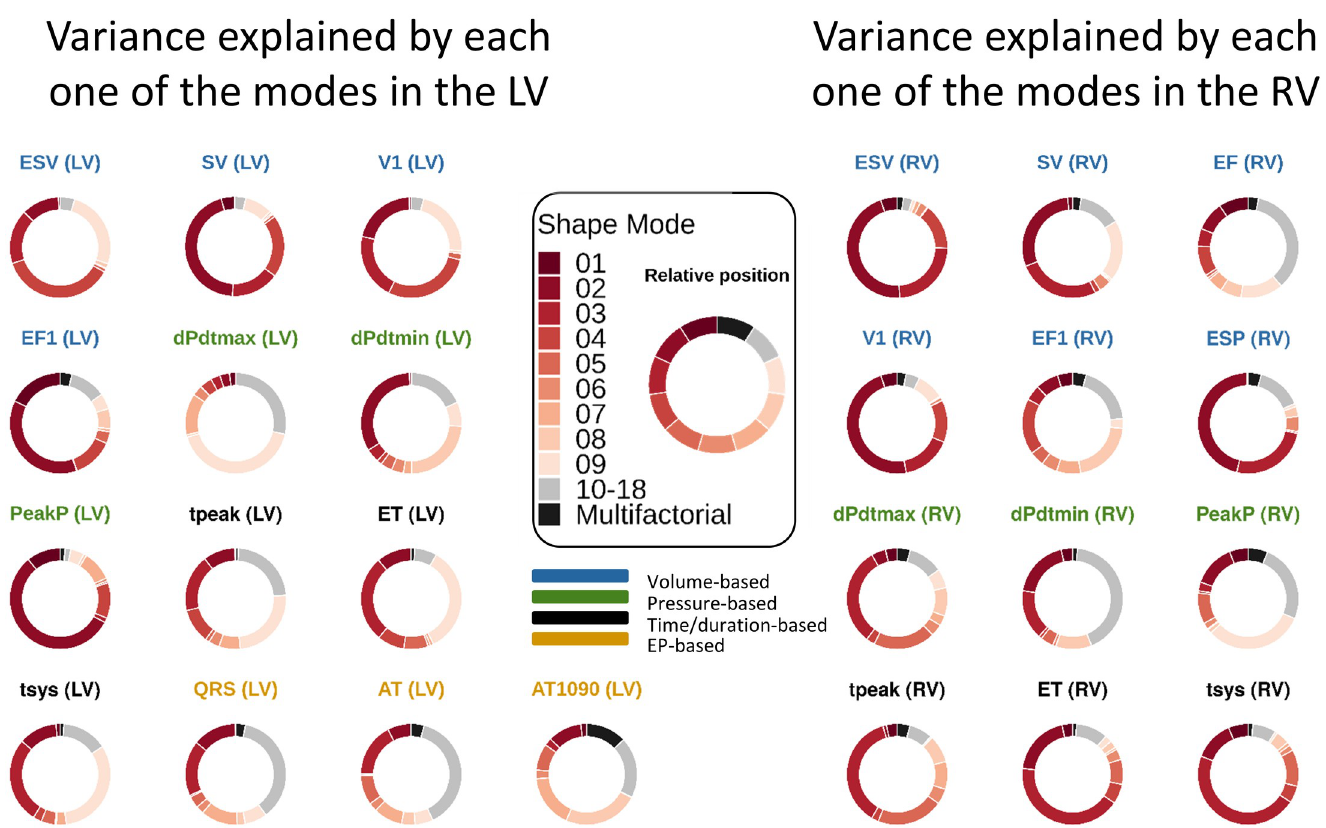
Fig 9. GSA performed using GPEs. A different GP has been used for each one of the phenotype. The bigger the slice in the doughnut chart, the more variance is explained globally by that mode as a first order effect. Interrelations between modes are encompassed in the multifactorial effects. The relative position between modes is consistent across the charts, as indicated in the legend in the centre. The titles of the doughnut charts are colour-coded according to the group of phenotypes they belong to.